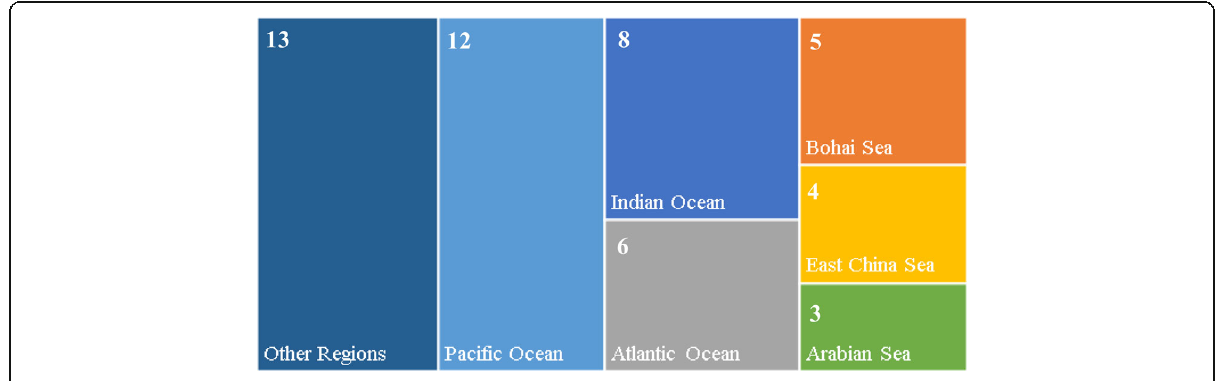
Fig. 3 Number of SST prediction studies per